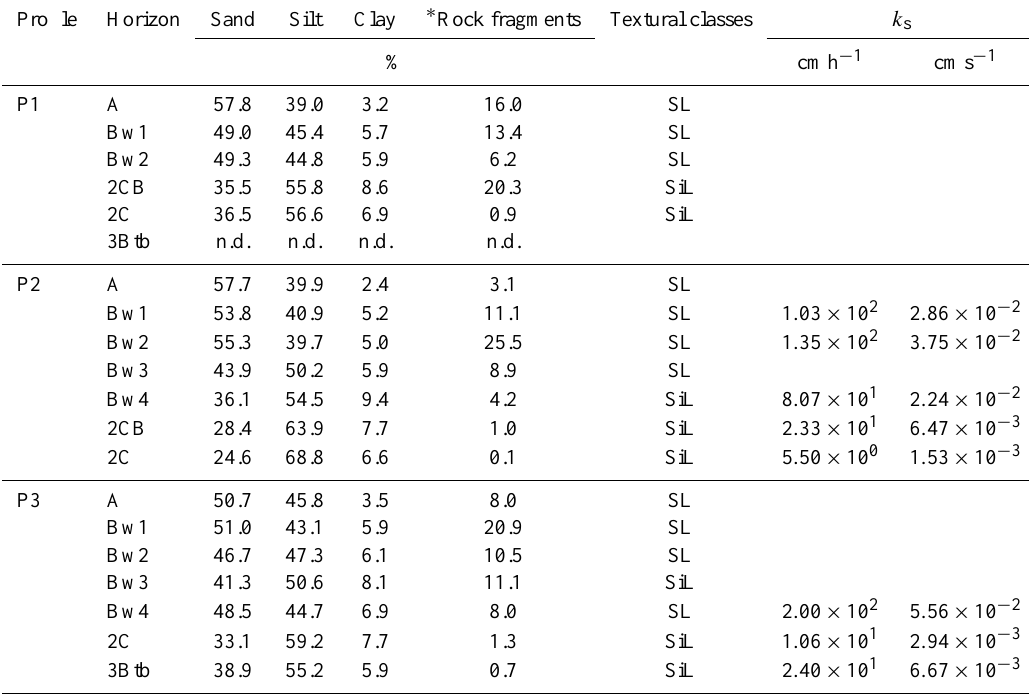
Table 4. Particle size distribution (PSD) and saturated hydraulic conductivity ( k s ).